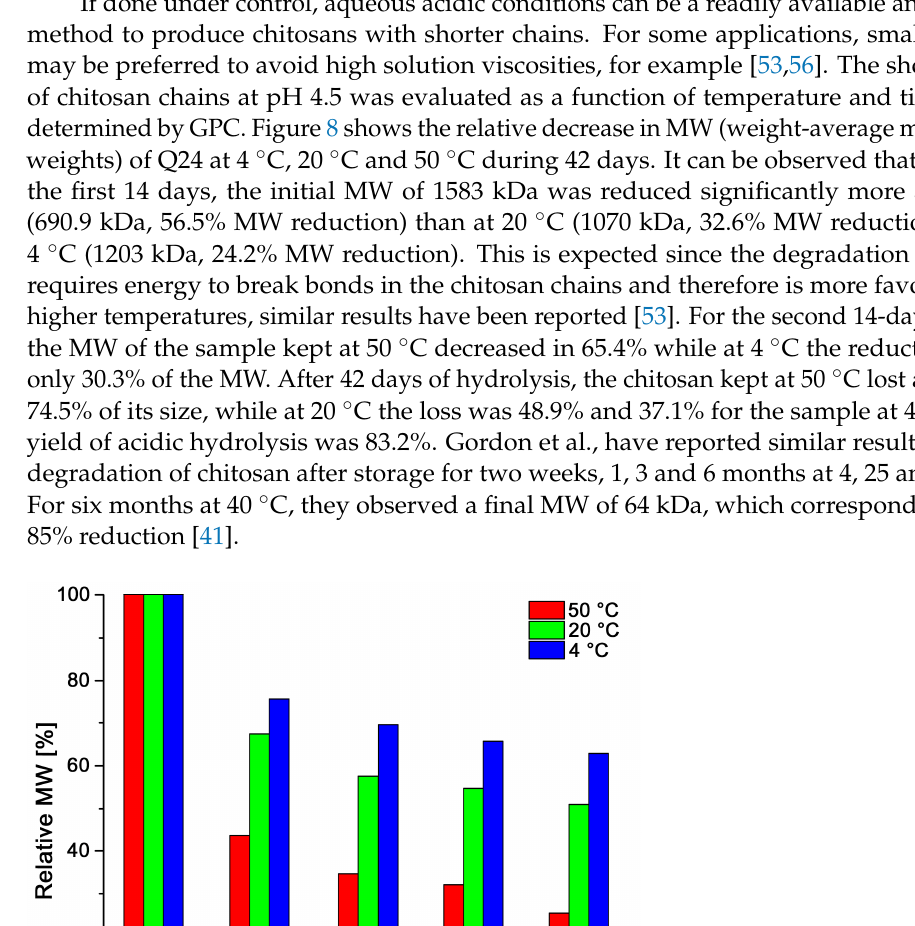
Figure 9. GPC chromatograms of chitosan stored at 50 °C for 0, 14, 28 and 35 days. 3.4. Chitosan MW Reduction by Ultrasound There is a consensus that when exposed to low frequency ultrasound, chain cleavage is mainly due to mechanical forces produced during cavitation [45,57] and it has been reported to be a fast method to reduce its MW [46,47,58]. Interestingly, Baxter et al. and Wu et al. have reported that the degradation by ultrasound does not affect the DA of chi- tosan when short periods of ultrasound exposure are used [45,58]. However, there is evi- dence in the literature that chitosan can be deacetylated considerably when treated exten- sively with ultrasound, for a long period of time and in strong alkaline conditions [59,60]. Figure 10 compares the GPC chromatograms for the initial chitosan, chitosan samples treated with ultrasound for one, two and three periods of 3 min each, and also a sample treated continuously for 9 min. The data attached to the figure corresponds to the weight- average MW obtained from the distribution for each product with the GPC software. The MW of all samples was reduced significantly with ultrasound treatment. As expected,